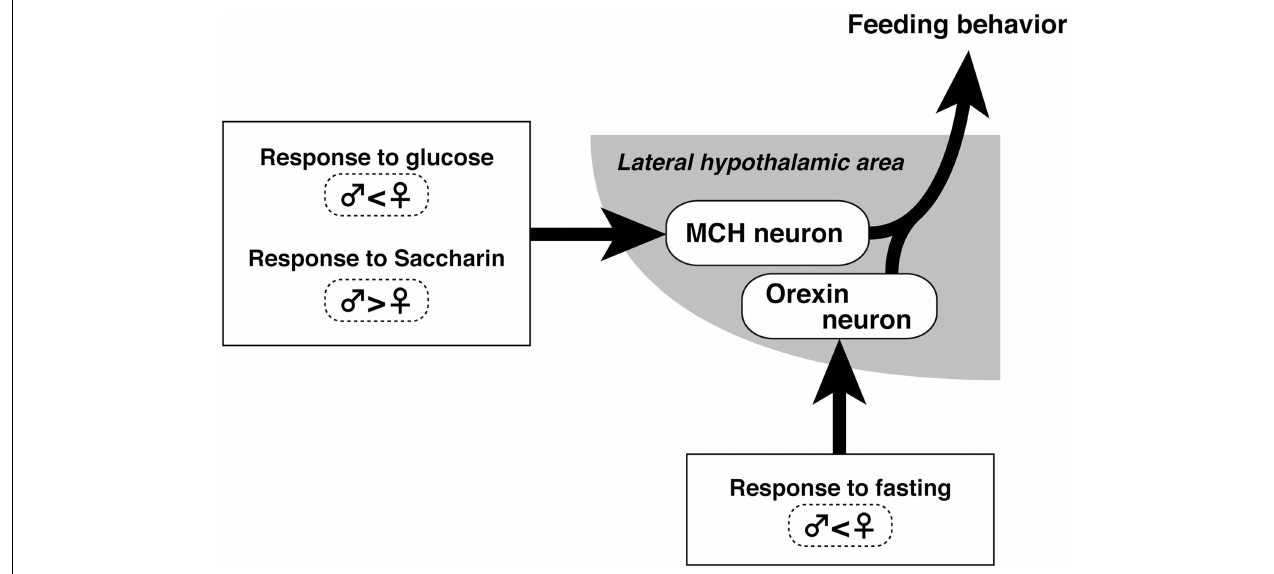
FIGURE 4 | Schematic of sex differences in MCH and orexin neuronal activity related to feeding control in the hypothalamus.